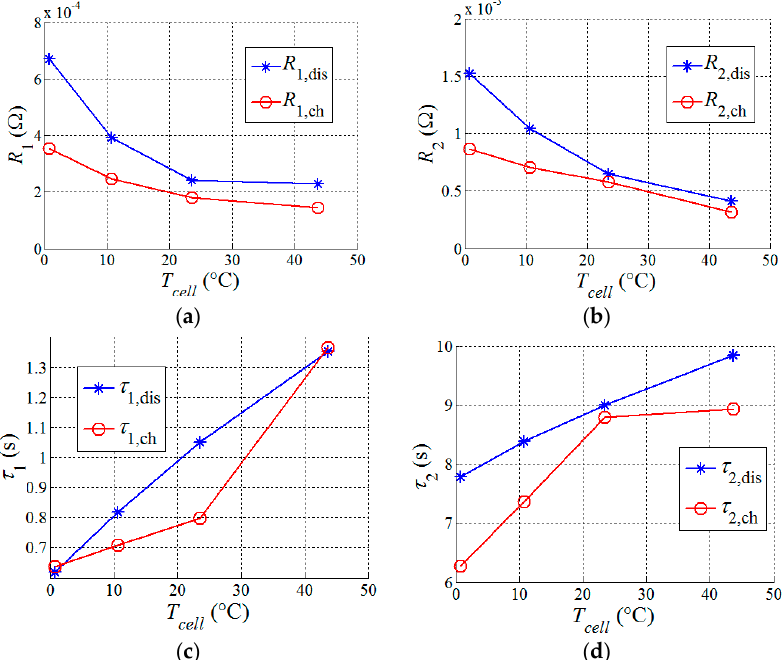
Figure A1. Model Parameters at different cell temperatures including ( a ) R 1 ; ( b ) R 2 ; ( c ) τ 1 and ( d ) τ 2 .